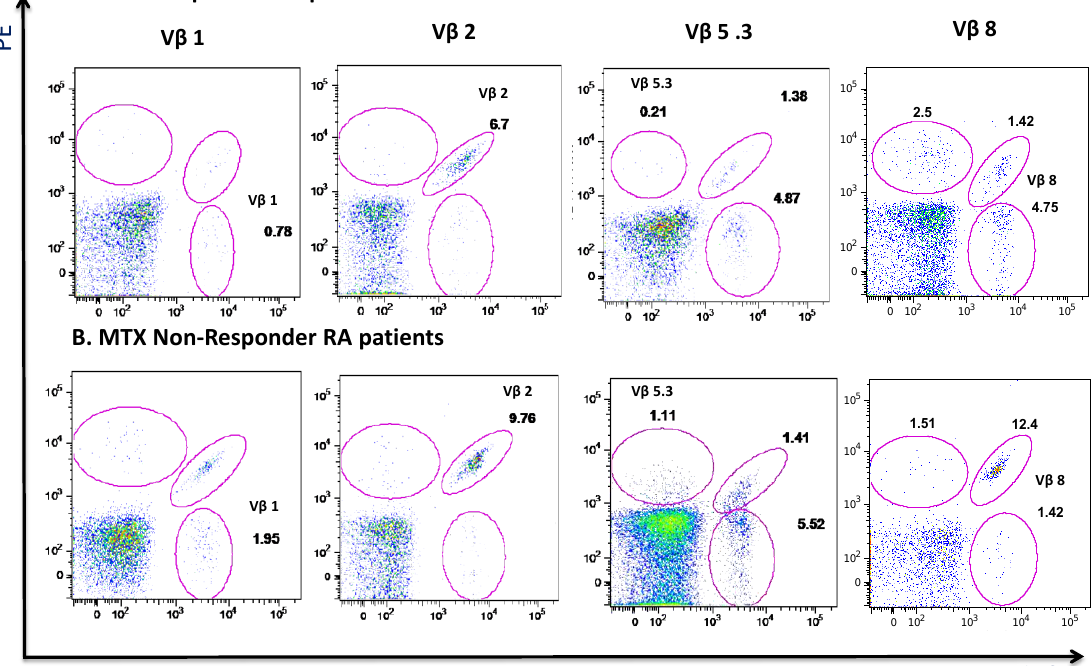
Figure 7. Representative dot-plot of V β expression in a responder and non-responder RA patients. Note. 1, 2, 5.3 and 8 V β repertoire distributions in CD4 + T EM lymphocytes in a representative responder ( A ) and non-responder ( B ) RA patients at baseline of MTX treatment.